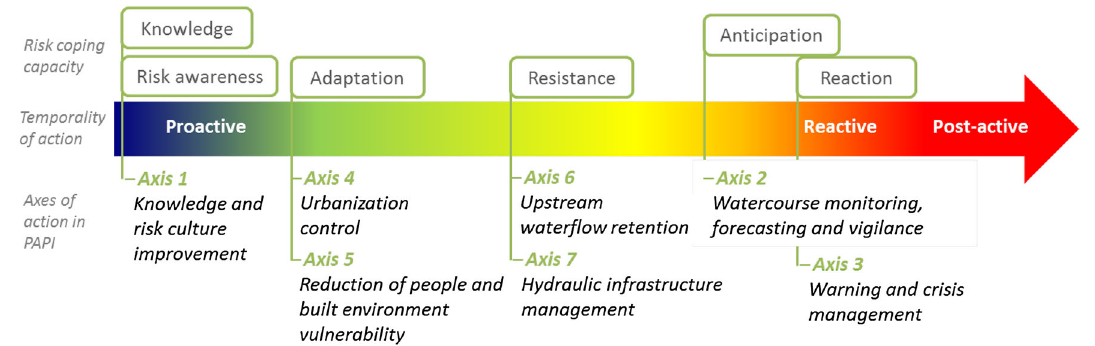
Fig. 2 The seven risk coping capacity axes of the French Action Programs for Flood Prevention (Programme d’Action pour la Pre´vention des Inondations—PAPI). Source : Adapted from Guillier (2016a,